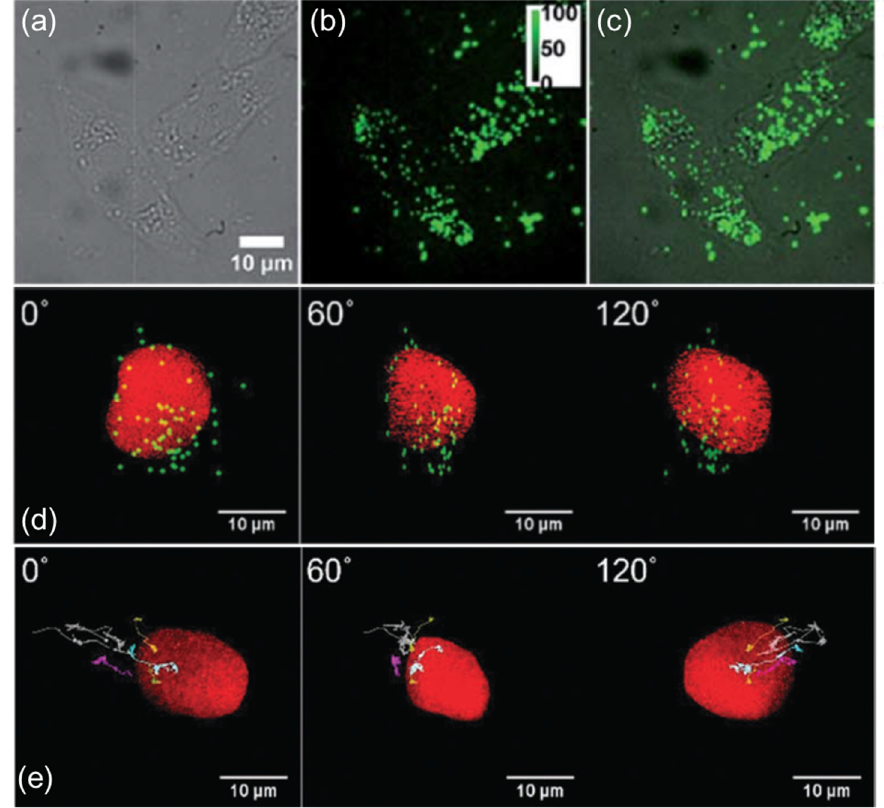
Figure Figure 3. 2D and 3D SPT images. ( a – c ) The fluorescence microscopy characterization of HeLa cells co- cultured with polymer-modified UCNPs. ( a ) bright-field, ( b ) fluorescence and ( c ) merged microscopy images [90]. ( d ) The images from various angles (at 0°, 60° and 120°) for UCNP–phospholipid–PEG- TAT. ( e ) The 3D trajectories from various angles (at 0°, 60° and 120°) for UCNP–phospholipid–PEG-